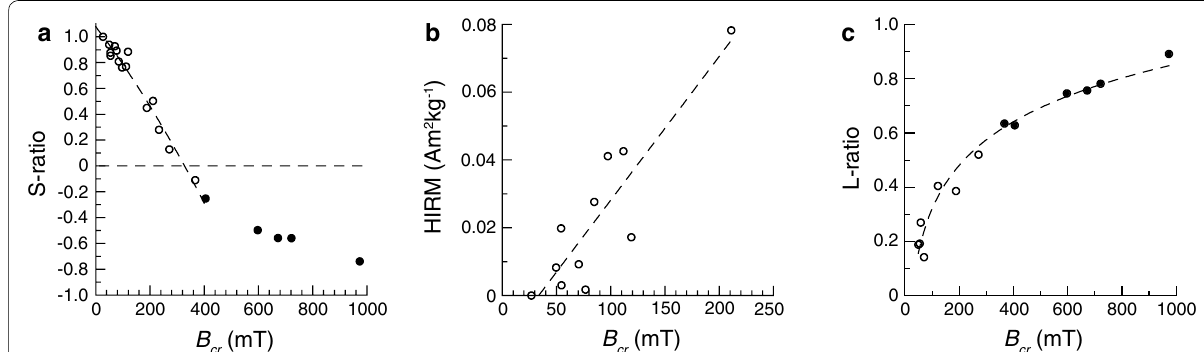
Fig. 3 Coercivity variations and their influence on S ‑ratio and HIRM. a S ‑ratio (Eq. 1) and b HIRM versus coercivity of remanence ( B cr ), where the S ‑ratio decreases with increasing coercivity and HIRM increases with increasing coercivity because more IRM is acquired above 300 mT as coercivity hardens. Such coercivity changes represent compositional differences in the analysed high‑coercivity minerals, which can be assessed with c the L ‑ratio. Constant L ‑ratio values indicate consistent magnetic properties of the high‑coercivity component, and changing values represent variable coercivity. Open circles represent synthetic Al‑substituted hematites and solid circles represent Al‑substituted goethites (Redrawn, including relationships for curve fits, from Liu et al.